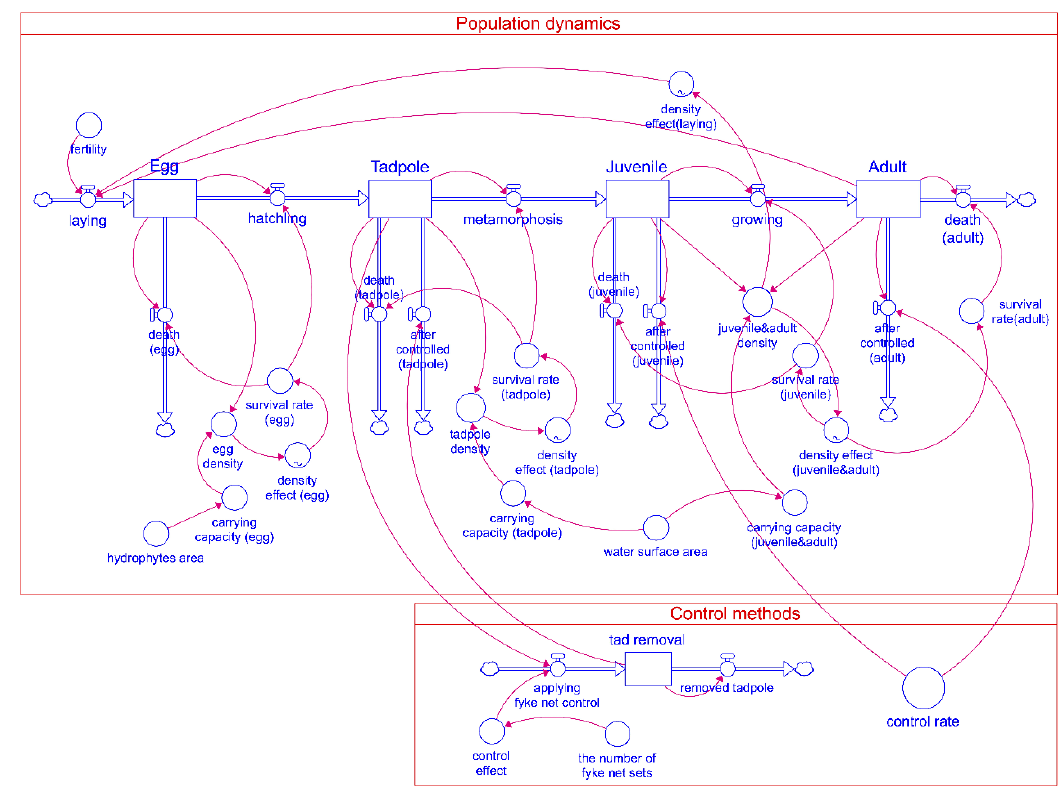
Figure 3. STELLA model for population dynamics of L. catesbeianus as affected by control methods. Table 1. Description of parameters used in the STELLA dynamic population model for each sector.